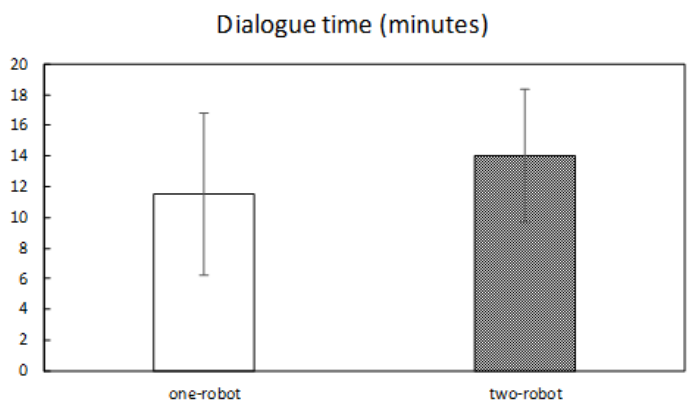
Figure 8. Averages of the dialogue time in each